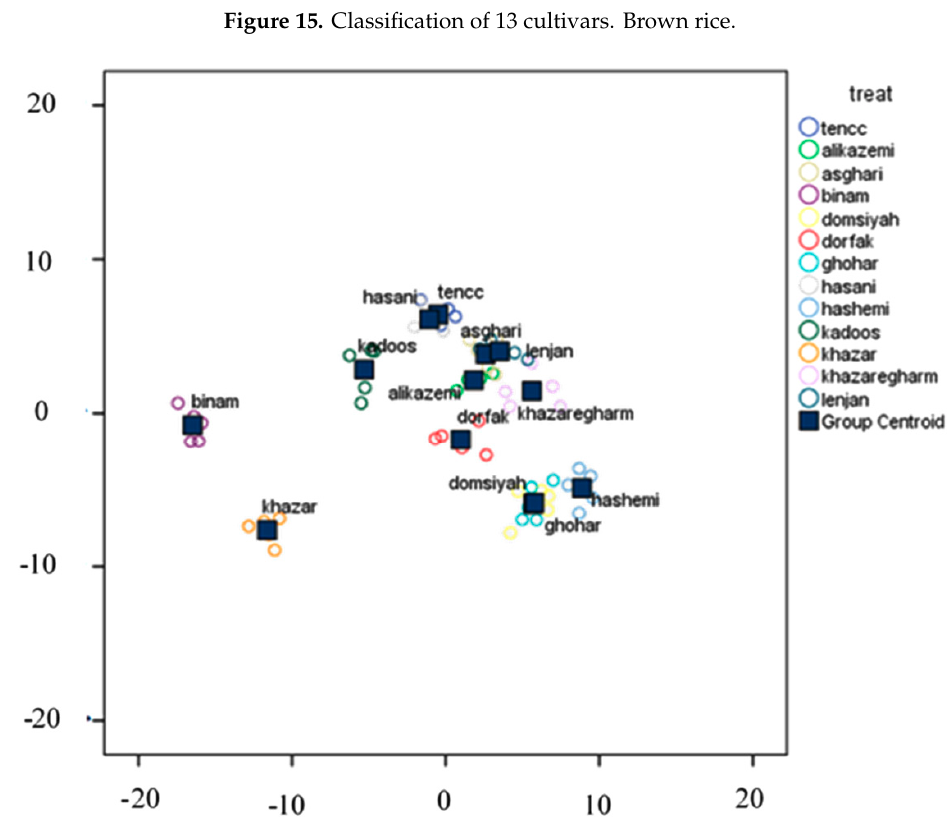
Figure 16. Classification of 13 cultivars. Paddy using linear discriminant analysis (DA).